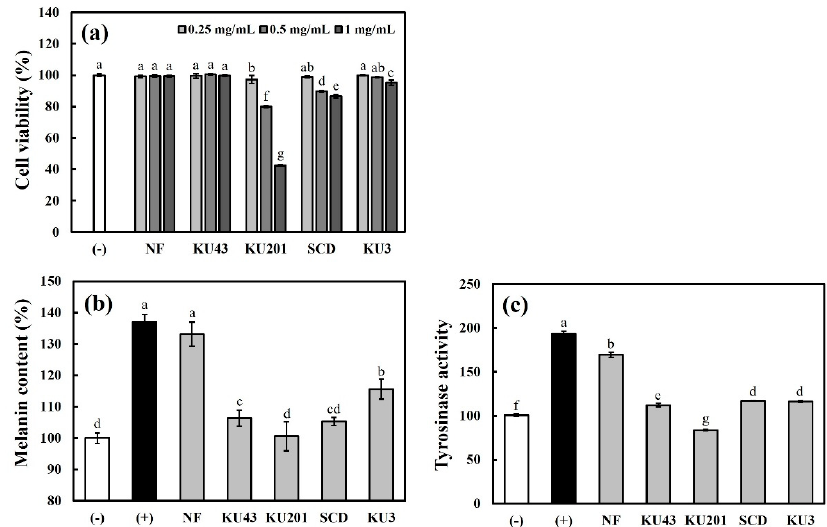
Figure 5. Cell viability, cellular melanin content, and cellular tyrosinase activity in B16F10 cells: ( a ) cell viability; ( b ) melanin content; ( c ) tyrosinase activity. ( − ): negative control without α -melanocyte- stimulating hormone ( α -MSH); (+): positive control with α -MSH; NF: nonfermented hydroponic ginseng (HG); KU43: HG fermented with B. subtilis KU43; KU201: HG fermented with B. subtilis KU201; SCD: HG fermented with B. polyfermenticus SCD; KU3: HG fermented with B. polyfermenticus KU3. The data are represented as means ± standard deviations of triplicates. Statistical differences ( p < 0.05) are represented with different letters above error bars.